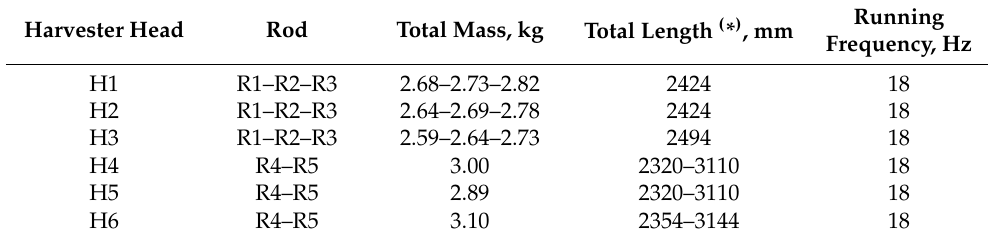
Table 3. Portable harvesters considered in this study. Harvester